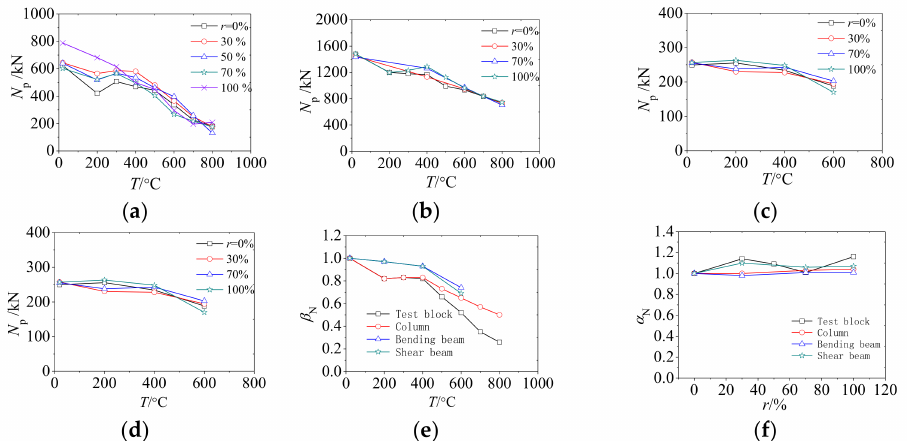
Figure 13. Bearing capacity degradation. ( a ) rectangular prisms specimens; ( b ) columns; ( c ) bending beams; ( d ) shear beams; ( e ) The influence of temperature; ( f ) The influence of replacement